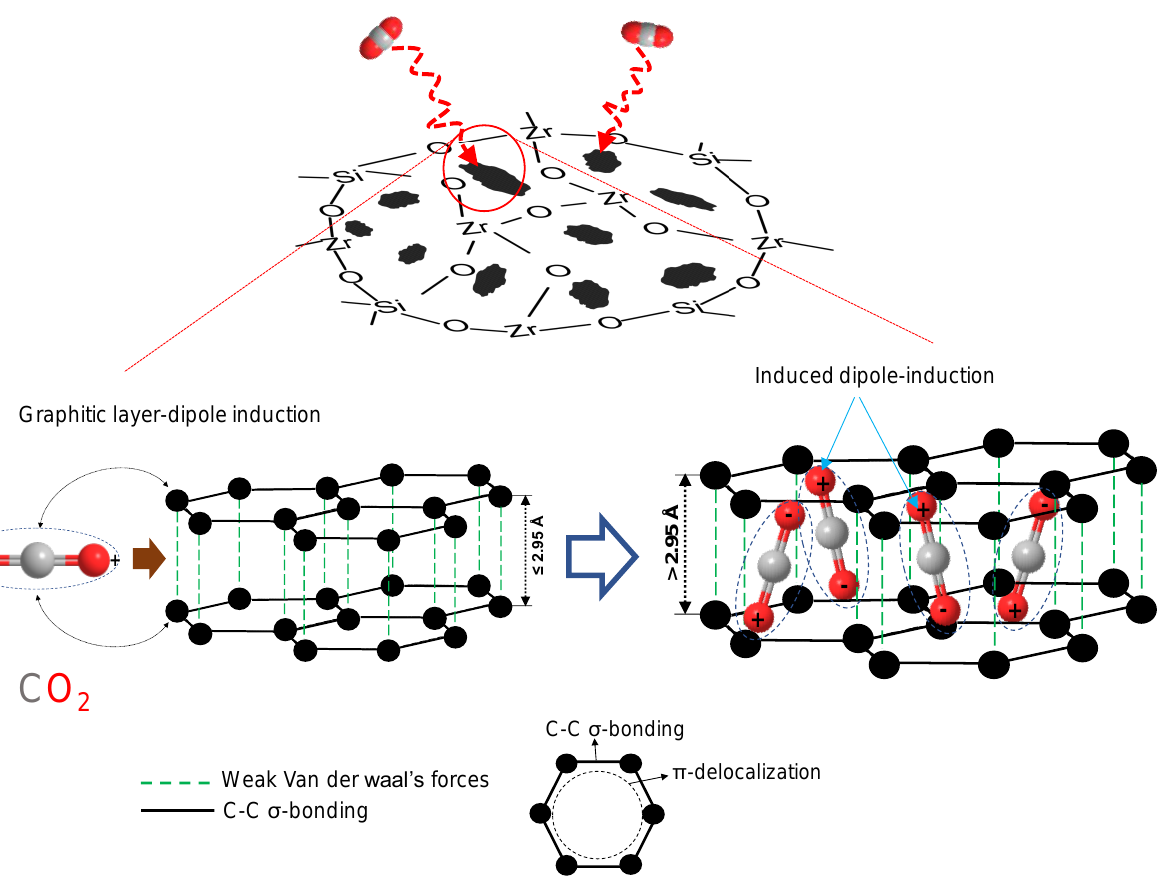
Figure 19. Schematic illustration of the mechanism of interaction between CO 2 and carbon nanopar- ticles in C-SiO 2 -ZrO 2 . Reproduced from [105].